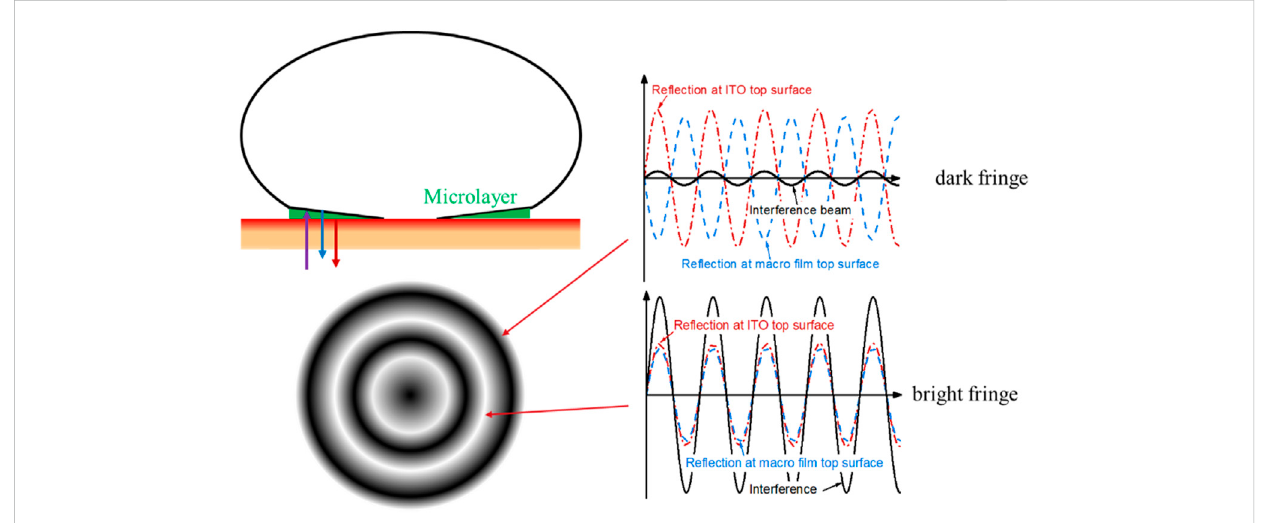
FIGURE 4 Principle of fi lm thickness measurement with laser interferometry.